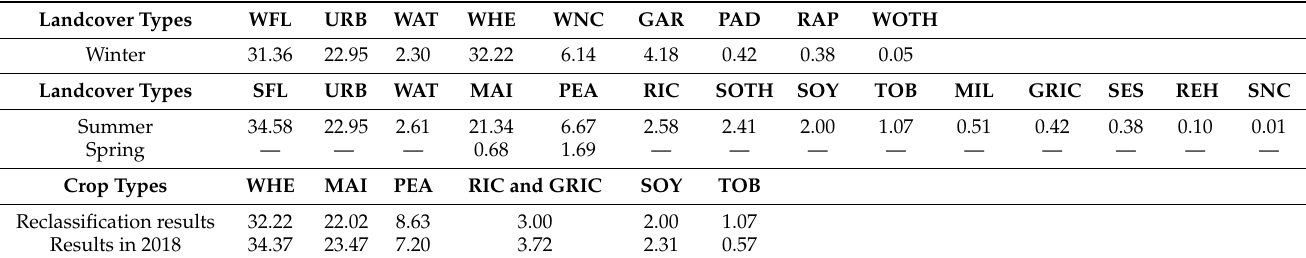
Table 5. Multi-season area proportion of different landcover types and comparison with the results in 2018 (%). Landcover